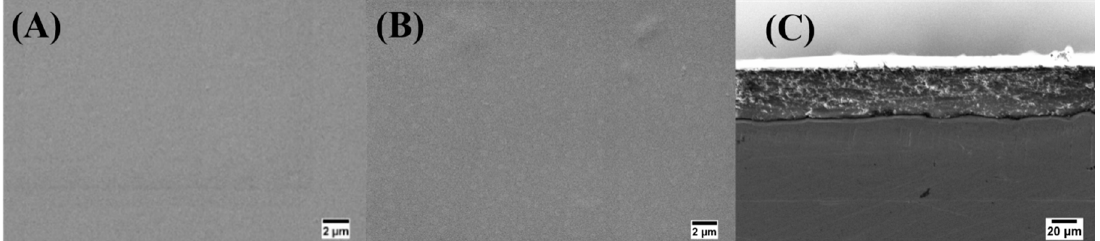
Figure 1. Scanning electron microscopy (SEM) morphologies of coatings ( A ) Chitosan (CS), ( B ) Copper(II)–Chitosan (Cu(II)–CS), and ( C ) cross-sectional image of Cu(II)–CS4, indicating a coating thickness of around 40 µ m.